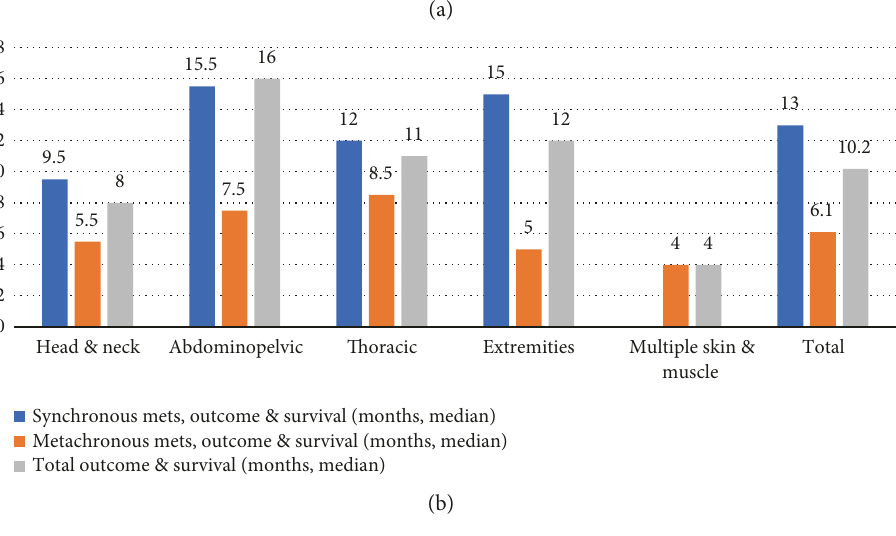
Figure 9: (a) Metastasis management. (b) Outcome and